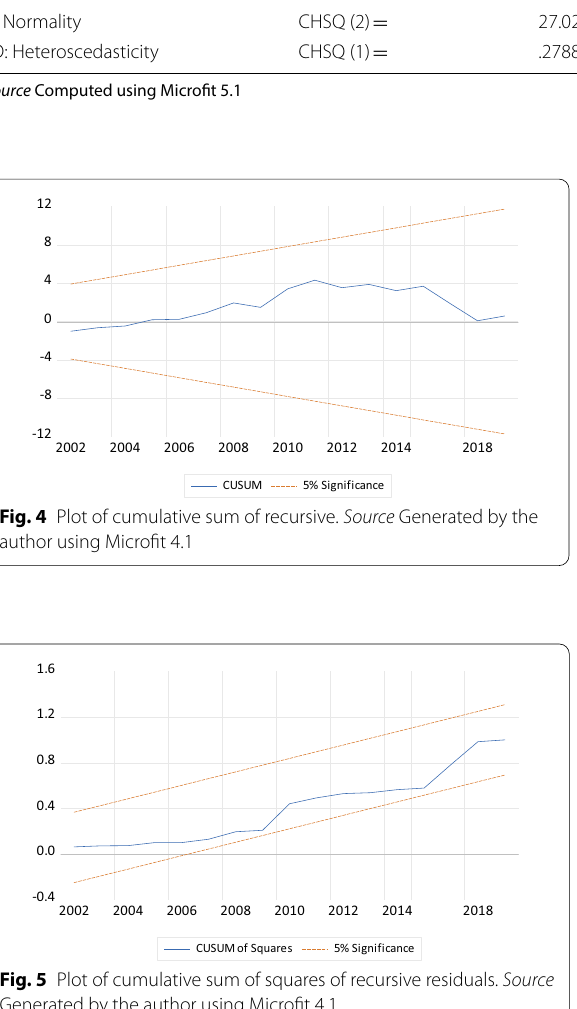
Source Computed using Microfit 5.1